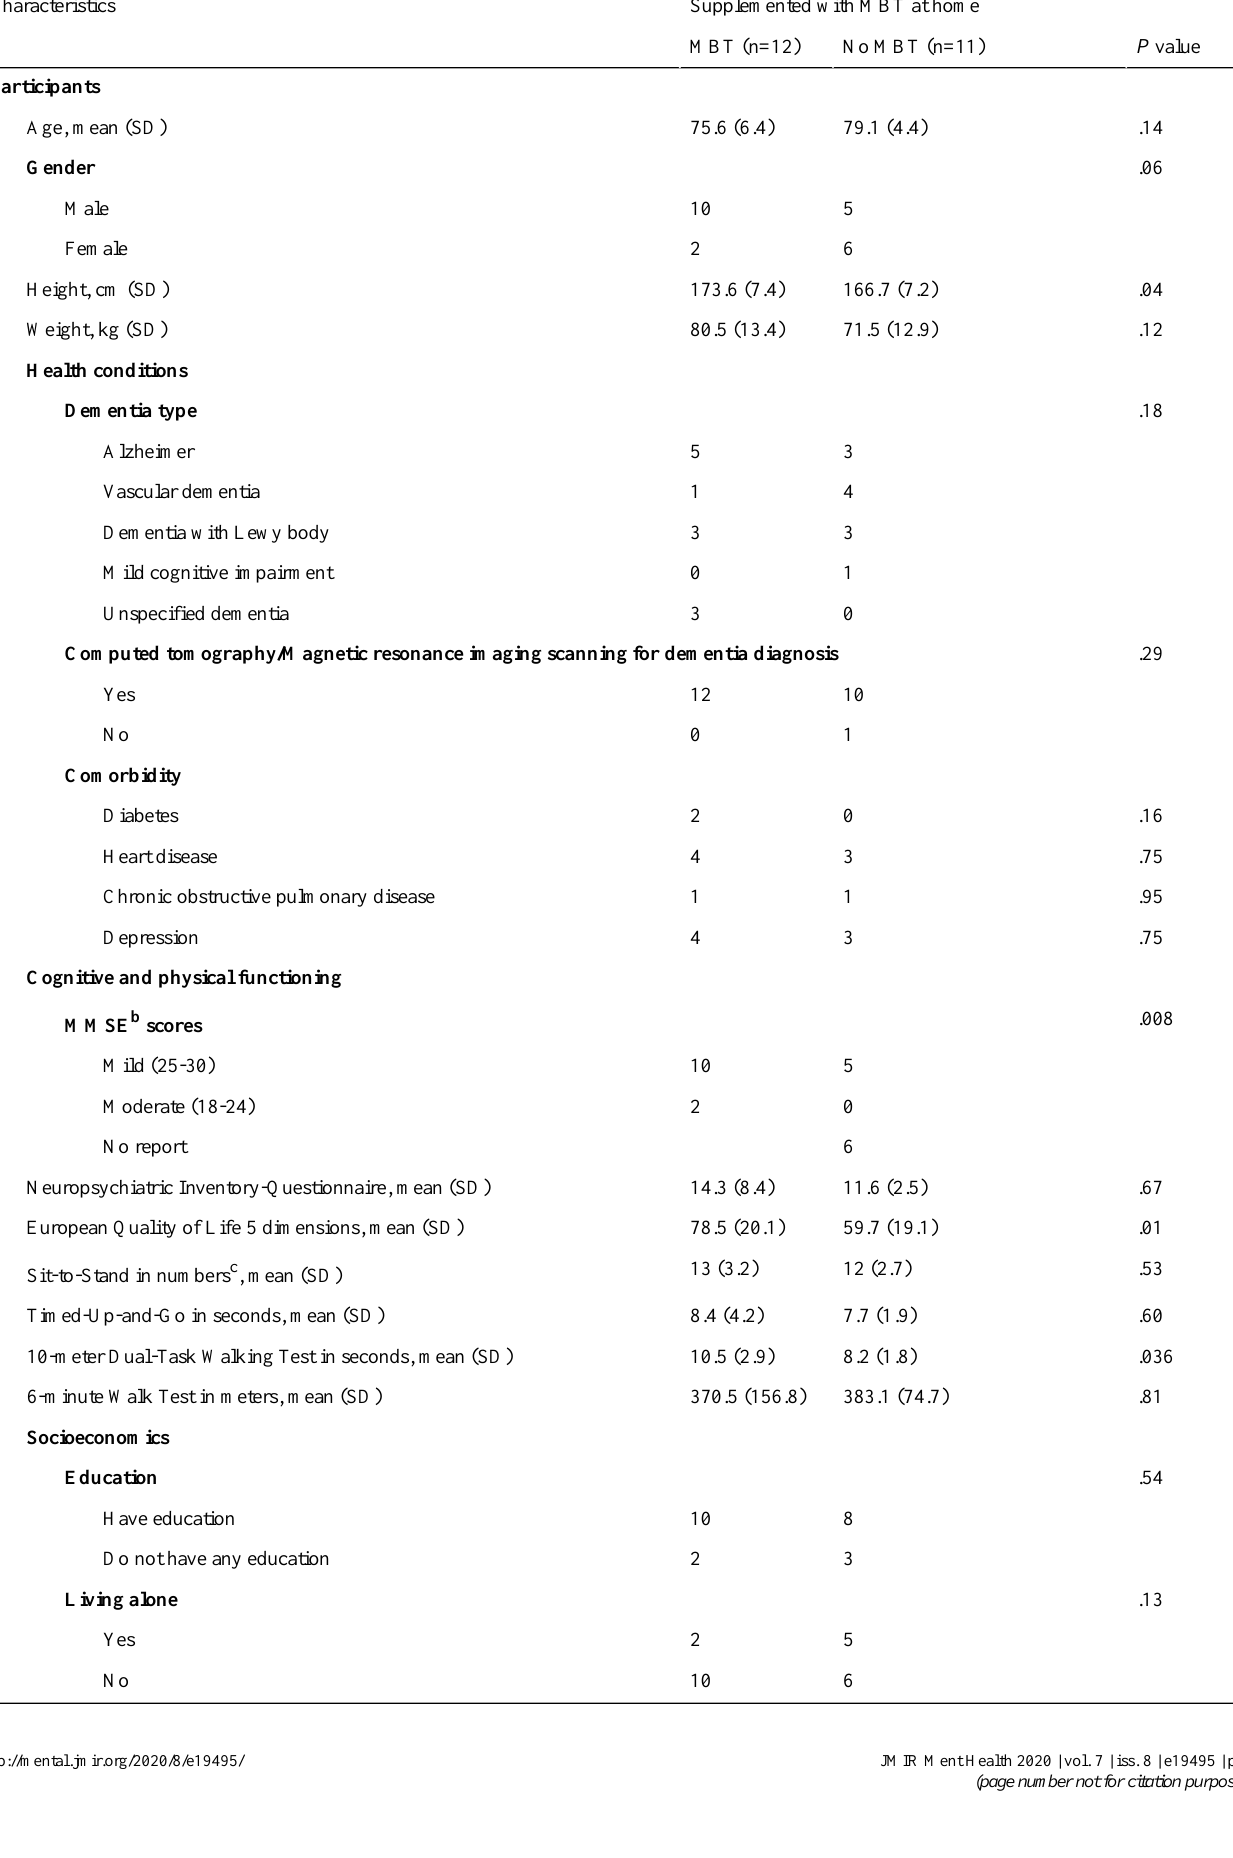
Supplemented with MBT at